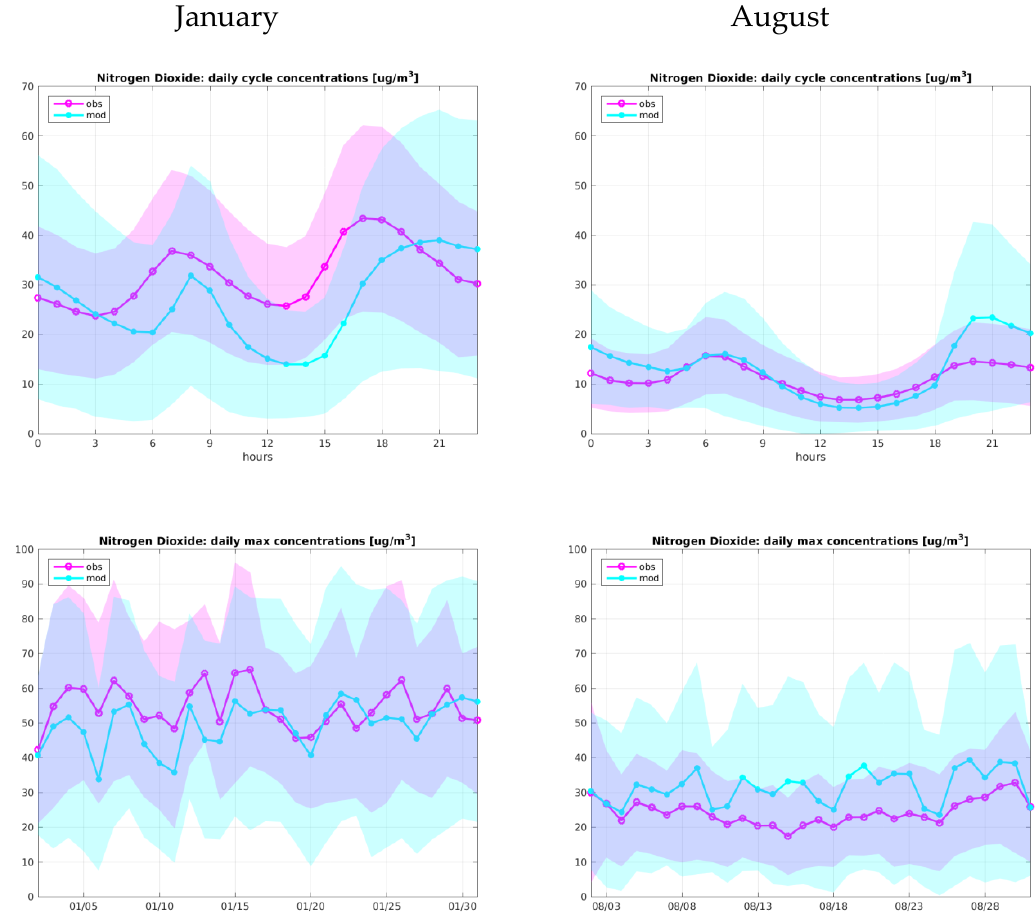
Figure 3. NO 2 —observed (violet) and modelled (light blue) average daily cycle of hourly concentrations (upper panel) and average daily maximum of hourly concentrations (lower panel), for January (left) and August (right). The dotted line is the average on all stations, the coloured strip is in the range of the 25th–75th percentiles of the values at stations. The x -axis reports UTC times.